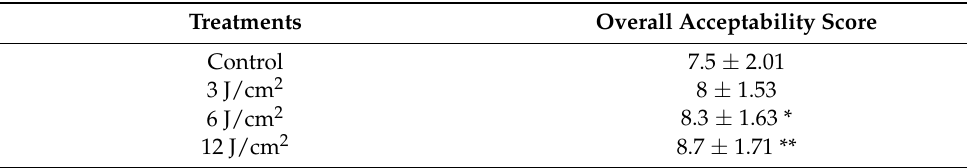
Table 5. Overall acceptability score of different labneh treatments.